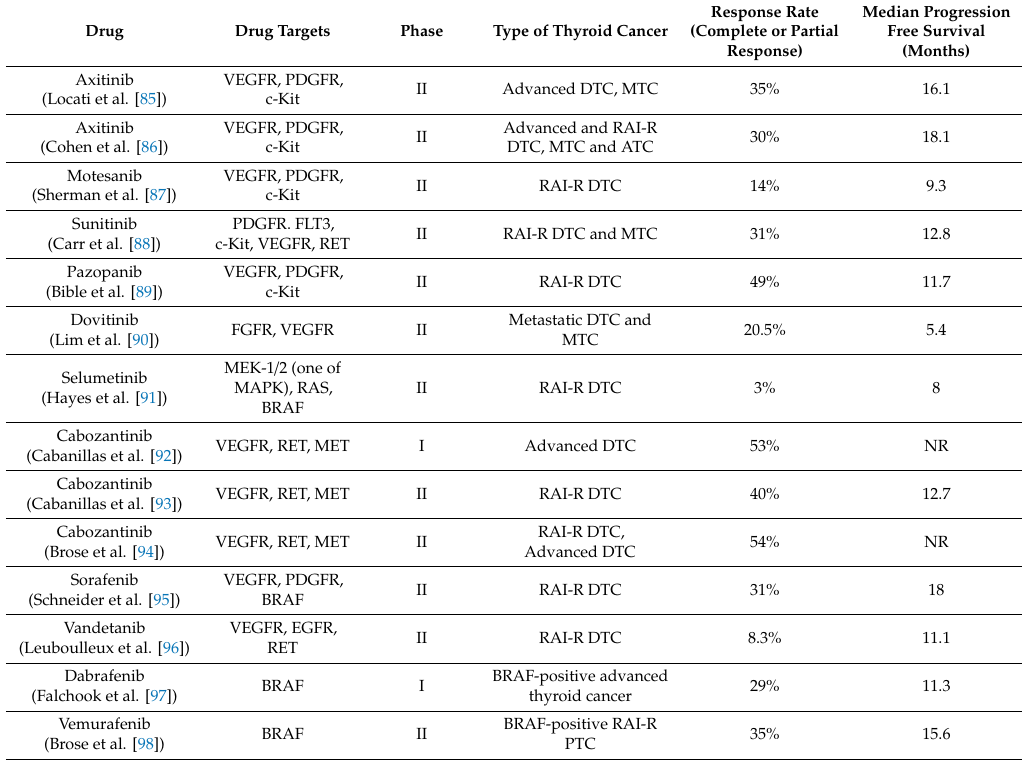
Table 2. Phase I and II Trials of Multi-Kinase Inhibitors for RAI-R Thyroid Cancers.